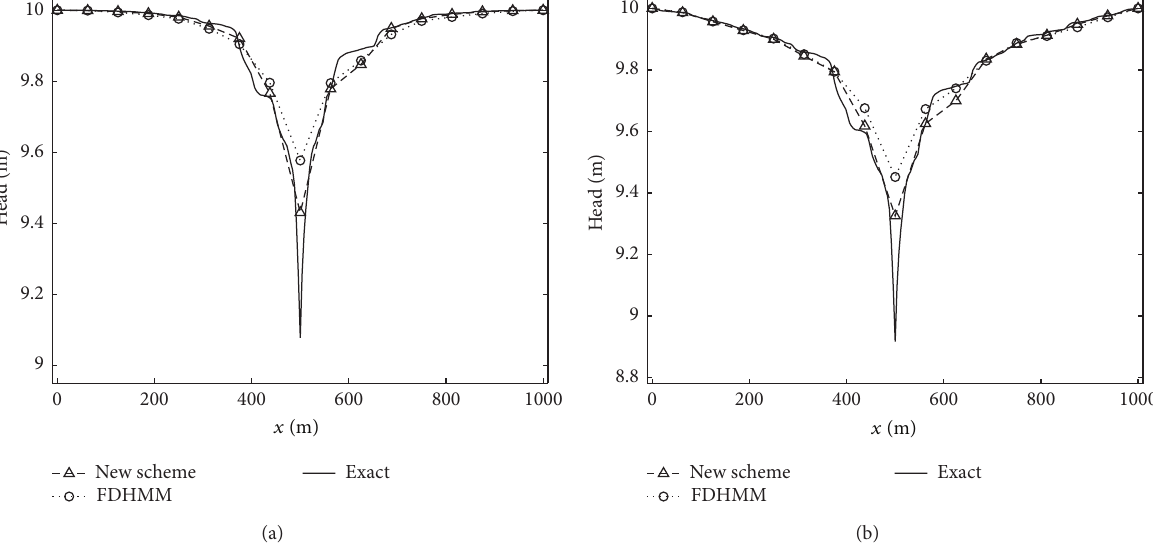
Figure 16: Exact solution and two coarse solutions at times (a) 𝑡 = 200 min and (b) 1000min in section 𝑦 = 500 m for the transient flow problem with weak well